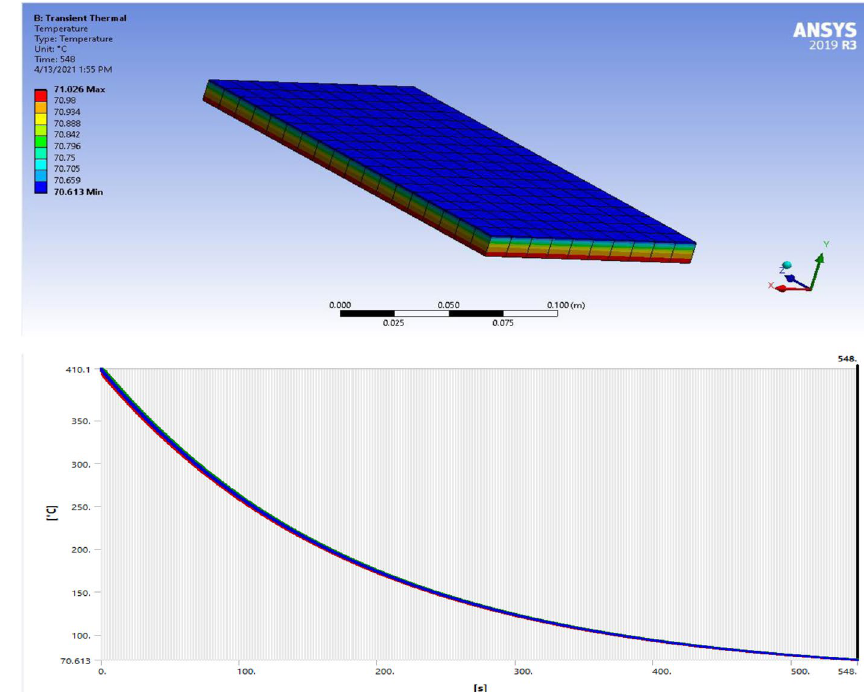
Fig. 16 CFD temp. controlled model and time plot at 110 °C, D